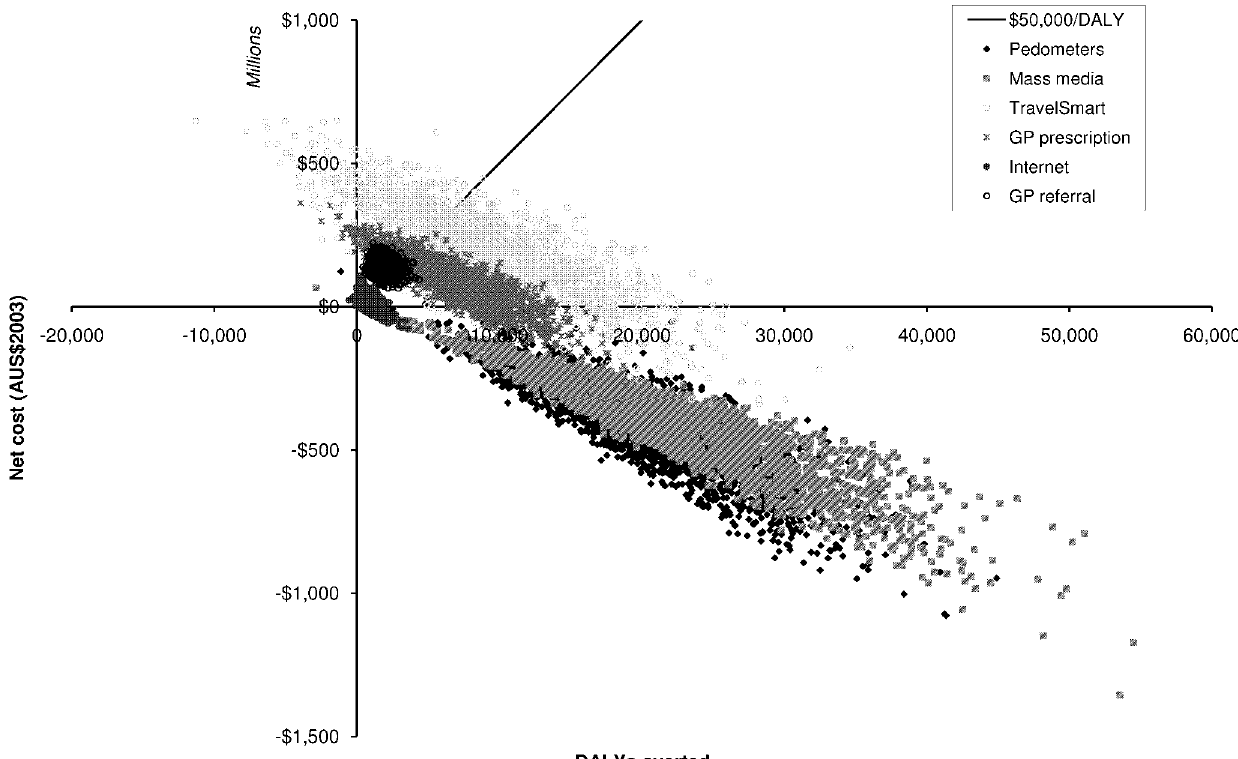
Figure 1. Cost-effectiveness of the physical activity interventions when compared with current practice.